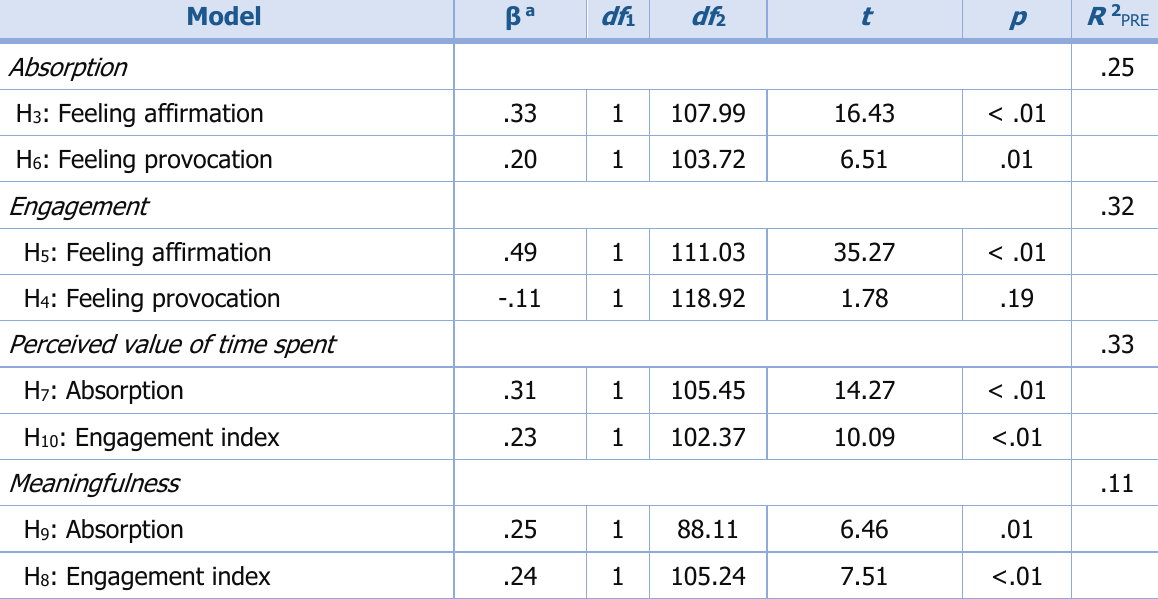
Table 4. Hypothesis Tests: Predictors of Absorption, Engagement, Perceived Value of Time Spent, and